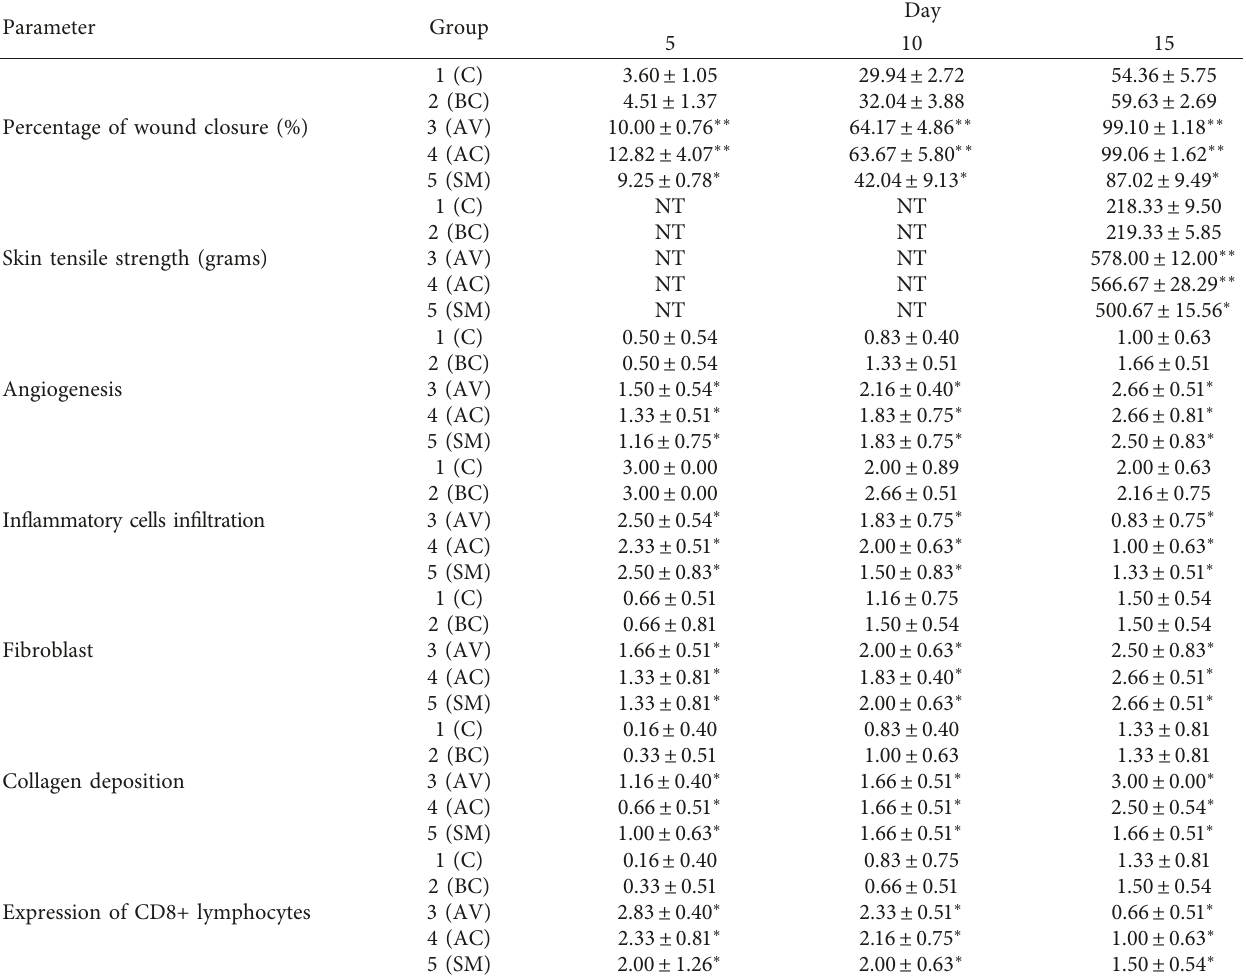
Table 3: Effects of the herbal cream formulation on the skin wound infected with